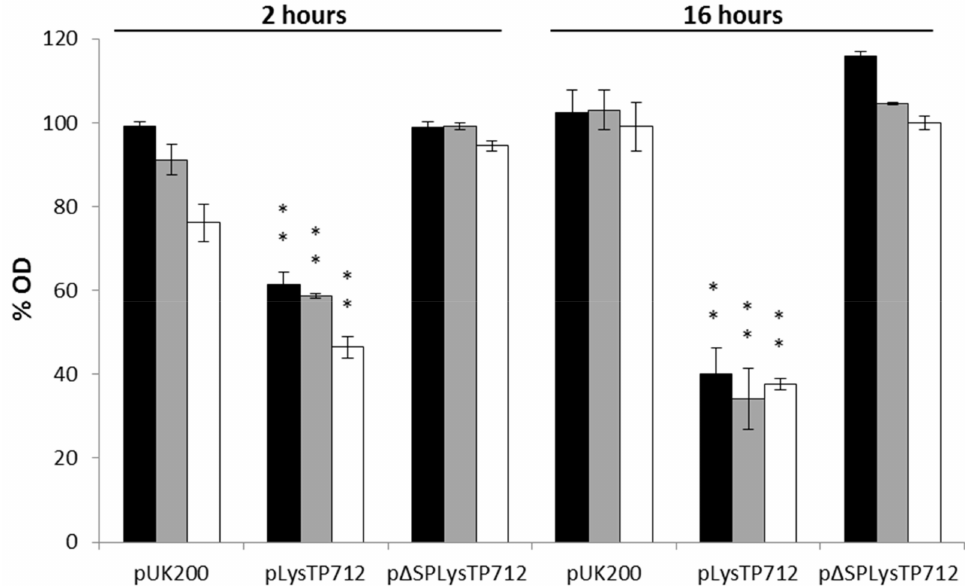
Figure 3. E ff ect of membrane depolarization on L. lactis NZ9000 after synthesis of LysTP712 with or without the signal peptide (pLysTP712 and p ∆ SPLysTP712, respectively). L. lactis NZ9000 cells carrying pLysTP712, p ∆ SPLysTP712, and pUK200 (empty plasmid) were induced with 2 ng / mL nisin at optical density (OD) of 0.4 and incubated at 30 ◦ C for 2 h. At this time (time zero), cell were treated with 12.5, 25 or 50 ng / mL concentration of nisin (black, grey, and white bars, respectively) or left untreated. OD was measured at 2 and 16 h after nisin exposure. The % OD, relative to non-treated cultures was taken as 100%. Each column represents the means from three independent experiments and error bars indicate the standard deviation. **, p < 0.01, significantly di ff erent to L. lactis